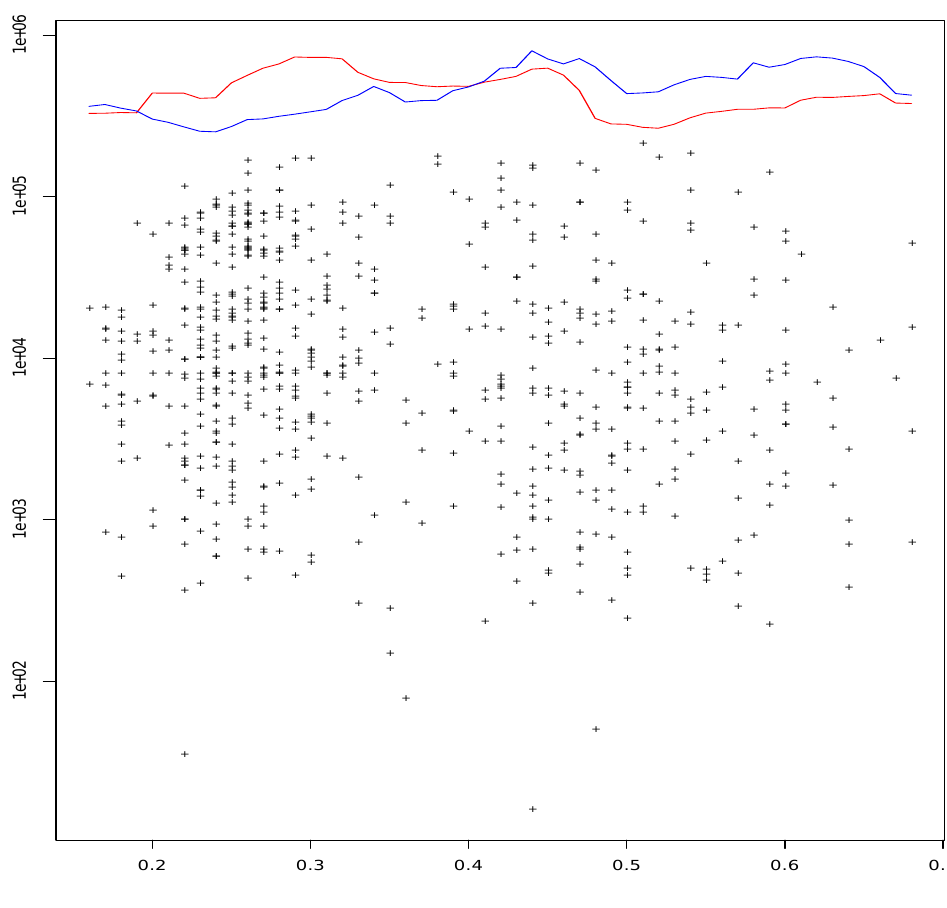
( α | ·) (blue) and semi-parametric n n , Y